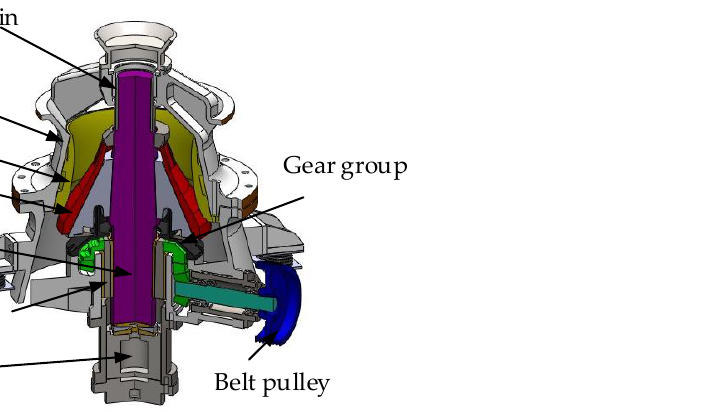
Figure 1. The cross-sectional view of the structure of a hydraulic cone crusher with a single hydraulic cylinder at the bottom.